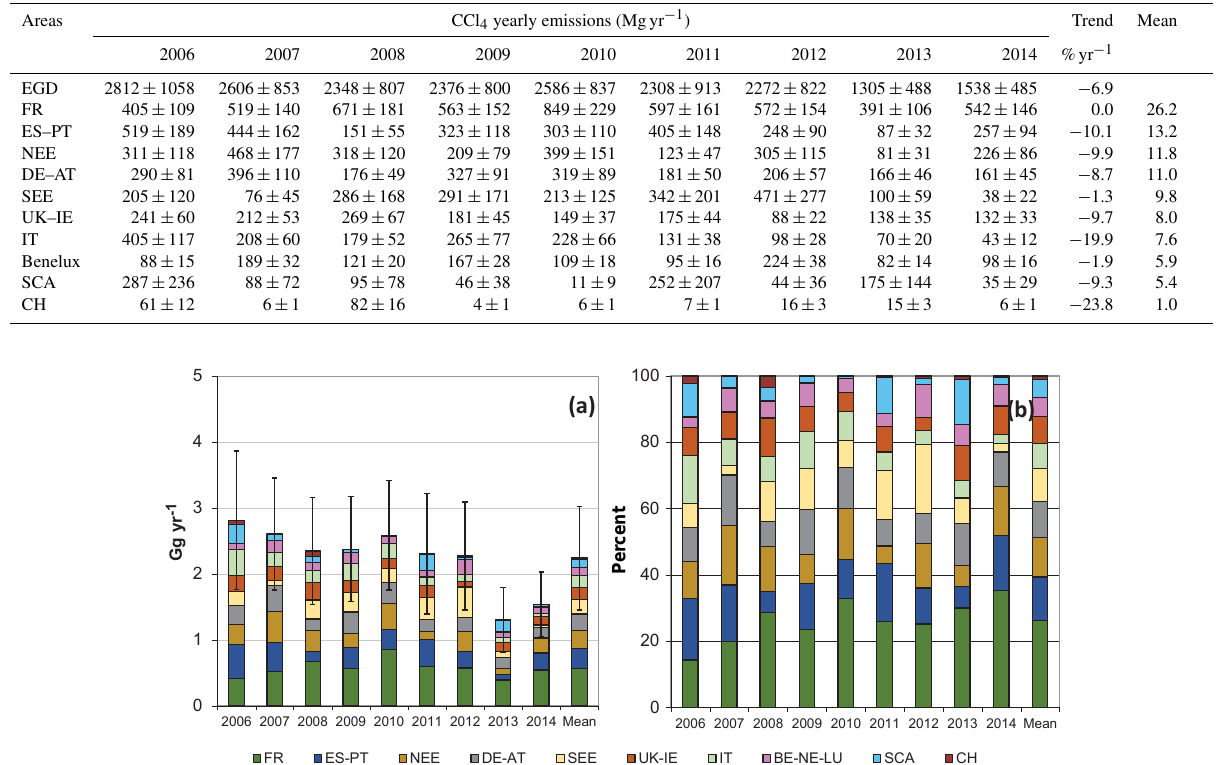
Table 1. Carbon tetrachloride emission estimates (Ggyr − 1 ) and associated uncertainty, percent yearly emission trends and 9-year average percent contributions from the European geographical domain (EGD) and from the 10 macro areas within the EGD over the study period. Macro areas listed according to their emission intensity are as follows: FR (France), ES–PT (Spain, Portugal), NEE (Poland, Czech Republic, Slovakia, Lithuania, Latvia, Estonia, Hungary, Romania, Bulgaria), DE–AT (Germany, Austria), SEE (Slovenia, Croatia, Serbia, Bosnia- Herzegovina, Montenegro, Albania, Greece), UK–IE (United Kingdom, Republic of Ireland), IT (Italy), SCA (Norway, Sweden, Finland, Denmark), Benelux (Belgium, the Netherlands, Luxembourg) and CH (Switzerland).